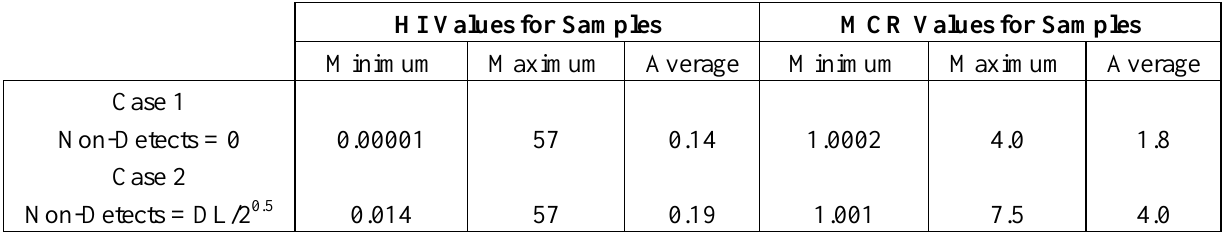
Table 4. Values of HI and MCR for samples in the final dataset.